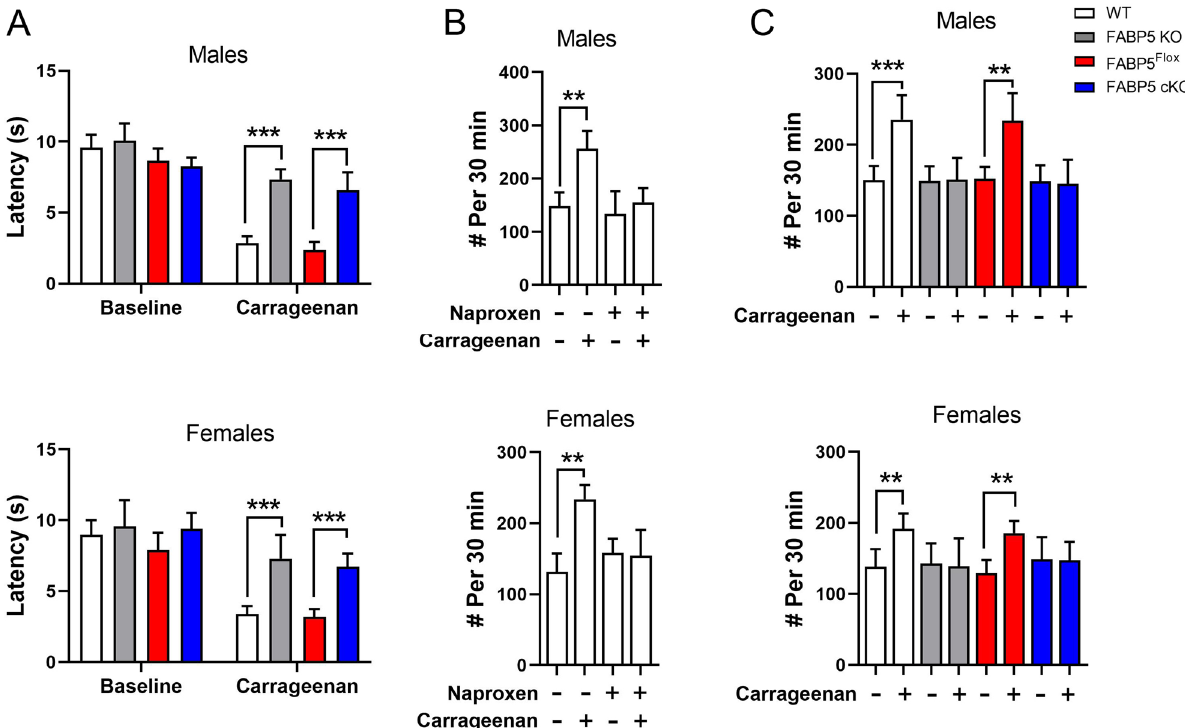
Figure 2. Deletion of FABP5 in nociceptors suppresses inflammatory hyperalgesia. ( A ) Thermal withdrawal latencies in male and female WT, FABP5 KO, FABP5 Flox , and FABP5 cKO mice at baseline and 4 h after intraplantar carrageenan injection. *** p < 0.001 calculated using one-way ANOVA followed by Tukey post-hoc test (n = 6). ( B ) Behavioral spectrometer analysis of still behavior at baseline and after carrageenan injection in WT male and female mice administered naproxen (30 mg/kg, i.p.) or vehicle. ** p < 0.01 calculated using paired t test (n = 6). ( C ) Still behavior in male and female WT, FABP5 KO, FABP5 Flox , and FABP5 cKO mice at baseline and 4 h after carrageenan injection. ** p < 0.01; *** p < 0.001 calculated using paired t test (n =